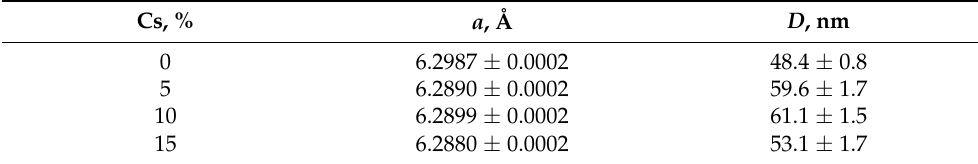
Table 1. Values of the lattice parameter a and crystalite size D determined by the